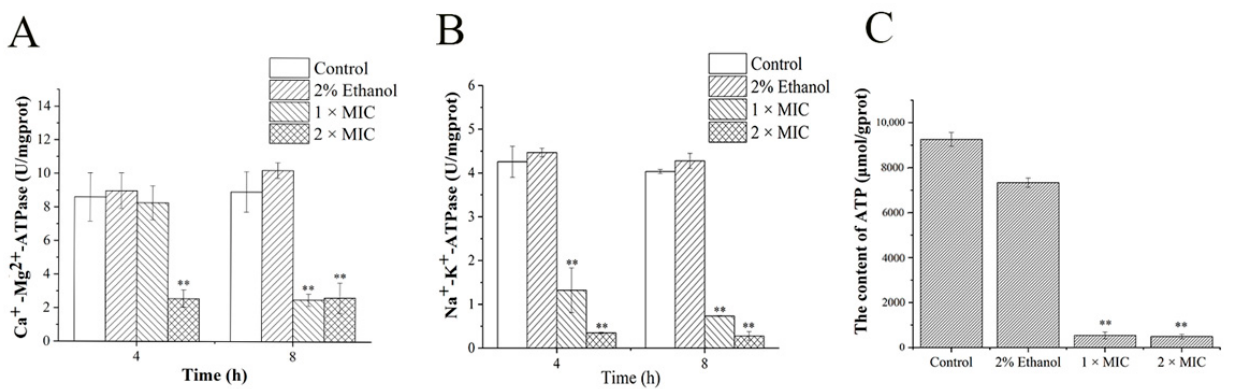
Figure 6. Effect of 3-carene on Ca 2+ -Mg 2+ -ATPase activity ( A ), Na+-K+-ATPase activity ( B ) and adenosine triphosphate (ATP) content ( C ). The asterisks indicate statistically significant differences compared with the control (** p < 0.01).